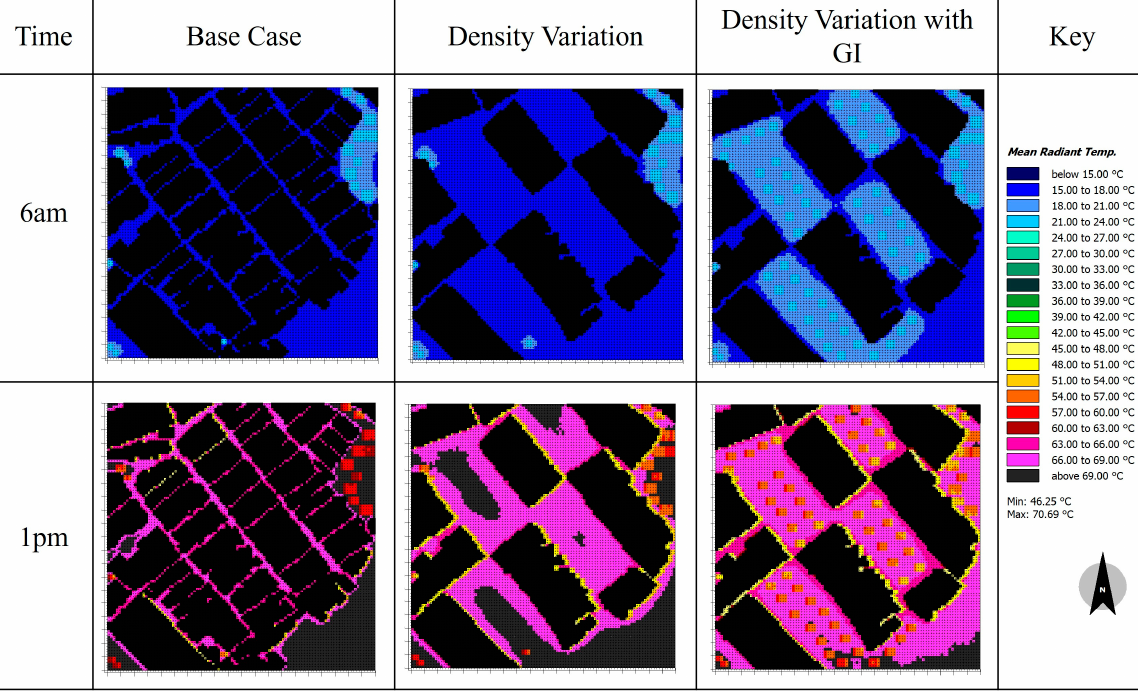
Figure 11. Spatial MRT variations at location 2 for 6 a.m. and 1 p.m.